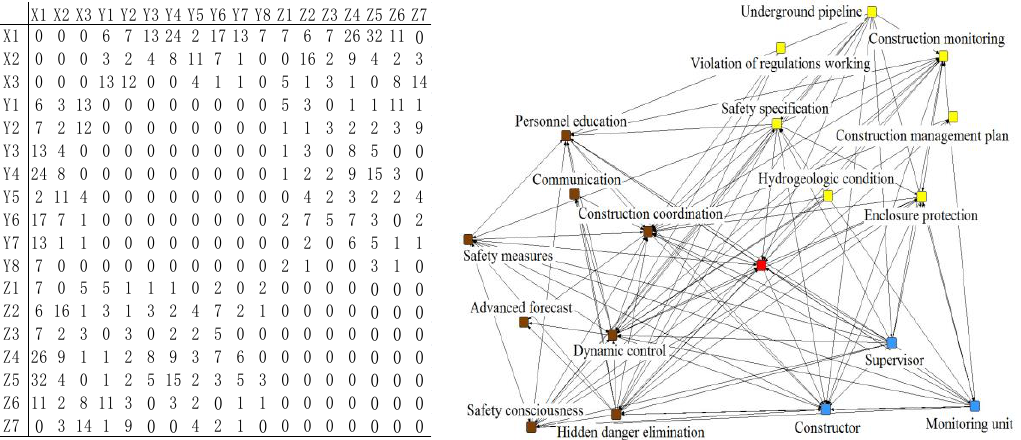
Figure 6. The co-occurrence matrix and the network structure.